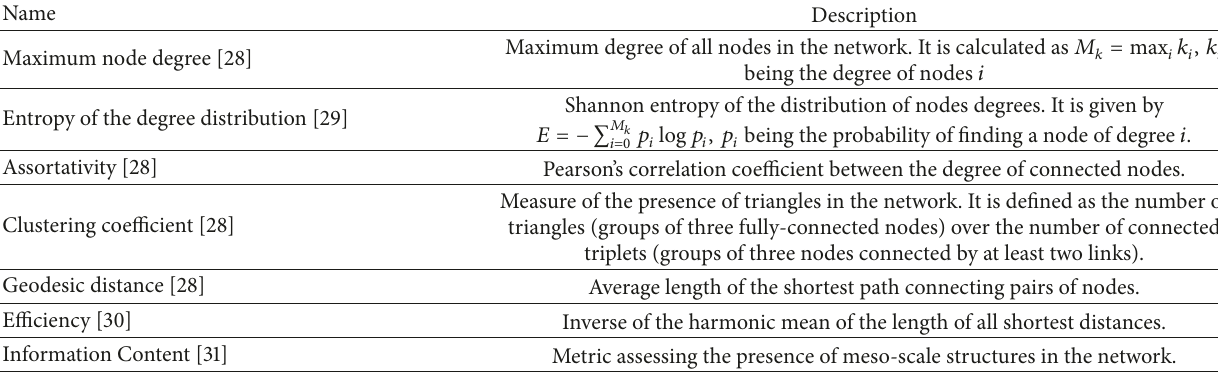
Table 2: List of topological metrics used to describe the structure of parenclitic networks.